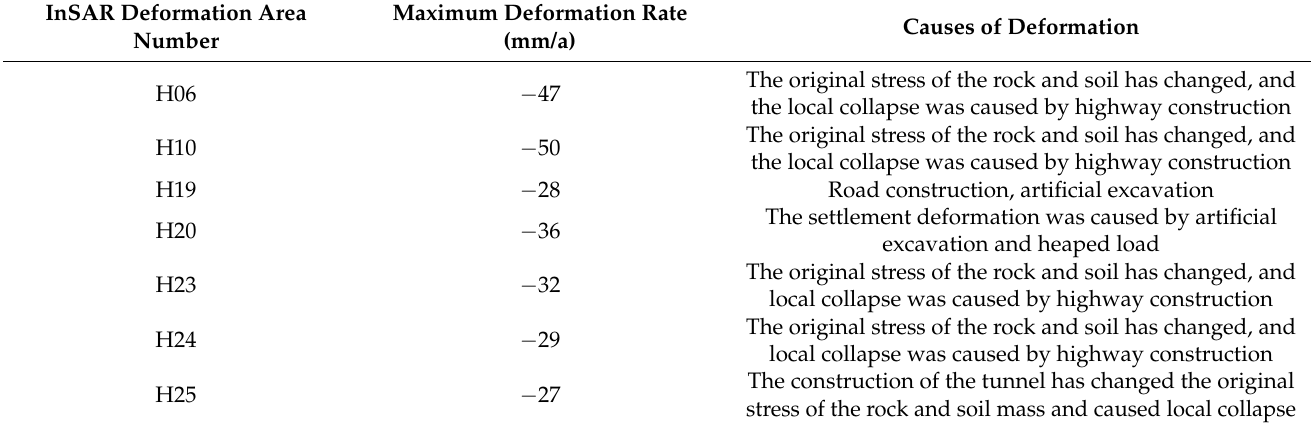
Table 4. Summary of information regarding human engineering